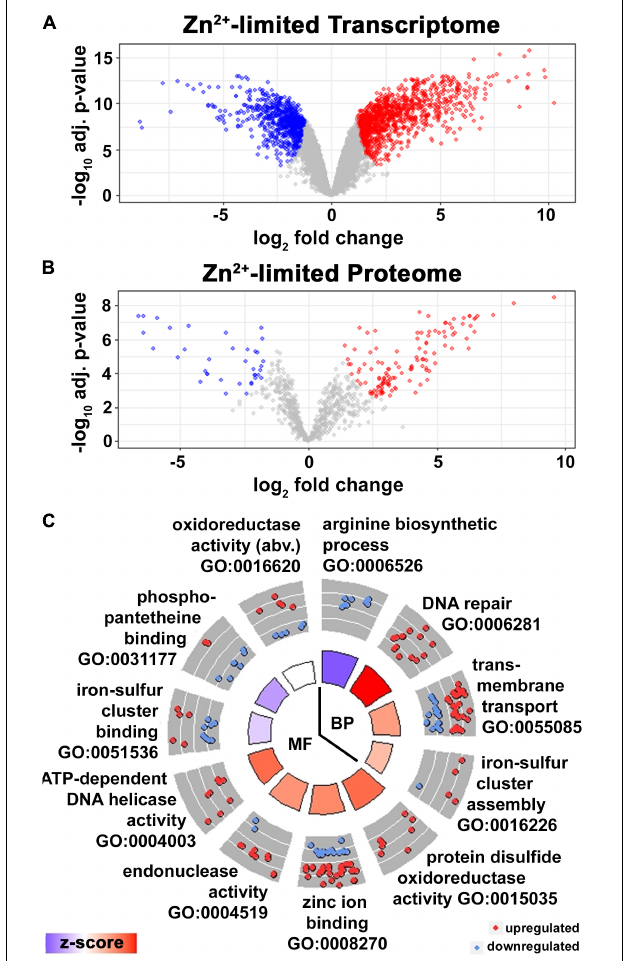
FIGURE 1 | Adaptive response to Zn 2 + limitation in Msm . (A) Volcano plot of DE transcripts (absolute lfc > 1, adj. p -Value < 0.05) in wild type Msm in ZLM vs. ZRM. Transcripts (data points) colored in red, blue, and gray are significantly upregulated, downregulated or not significantly regulated in ZLM vs. ZRM, respectively. Three independent biological replicates for each condition were used in the analysis. (B) Volcano plot of DE proteins (absolute lfc > 1, adj. p -Value < 0.05) in wild type Msm in ZLM vs. ZRM. Proteins (data points) colored in red, blue, and gray are significantly upregulated, downregulated or not significantly regulated in ZLM vs. ZRM, respectively. Three independent biological replicates for each condition were used in the analysis. (C) Circle plot showing GO terms of biological processes (BP) and molecular functions (MF) significantly enriched in the DE transcripts in wild type ZLM vs. ZRM ( p -Value < 0.05). Each slice of the circle is labeled with the enriched GO term, the outer circle shows a scatter plot of lfc values for DE genes with the given GO annotation, where red circles display upregulated and blue circles downregulated genes in wild type ZLM vs. ZRM. The color of bars in the inner circle correlates with the z-score which indicates whether the given biological process is more likely to be increased (red) or decreased (blue) in the dataset and the height of the bars represents the significance for the enriched term (larger bars have smaller p -Value). When necessary, the full-length description of some GO terms are abbreviated (abv.) for